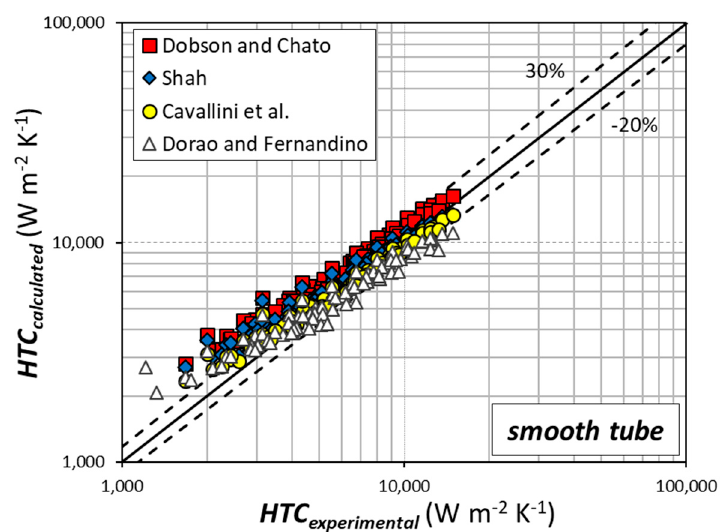
Figure 11. Experimental and calculated heat transfer coe ffi cients for the 2.5 mm ID smooth tube. Models developed by Dobson and Chato [28], Shah [29], Cavallini et al. [30], and Dorao and Fernandino